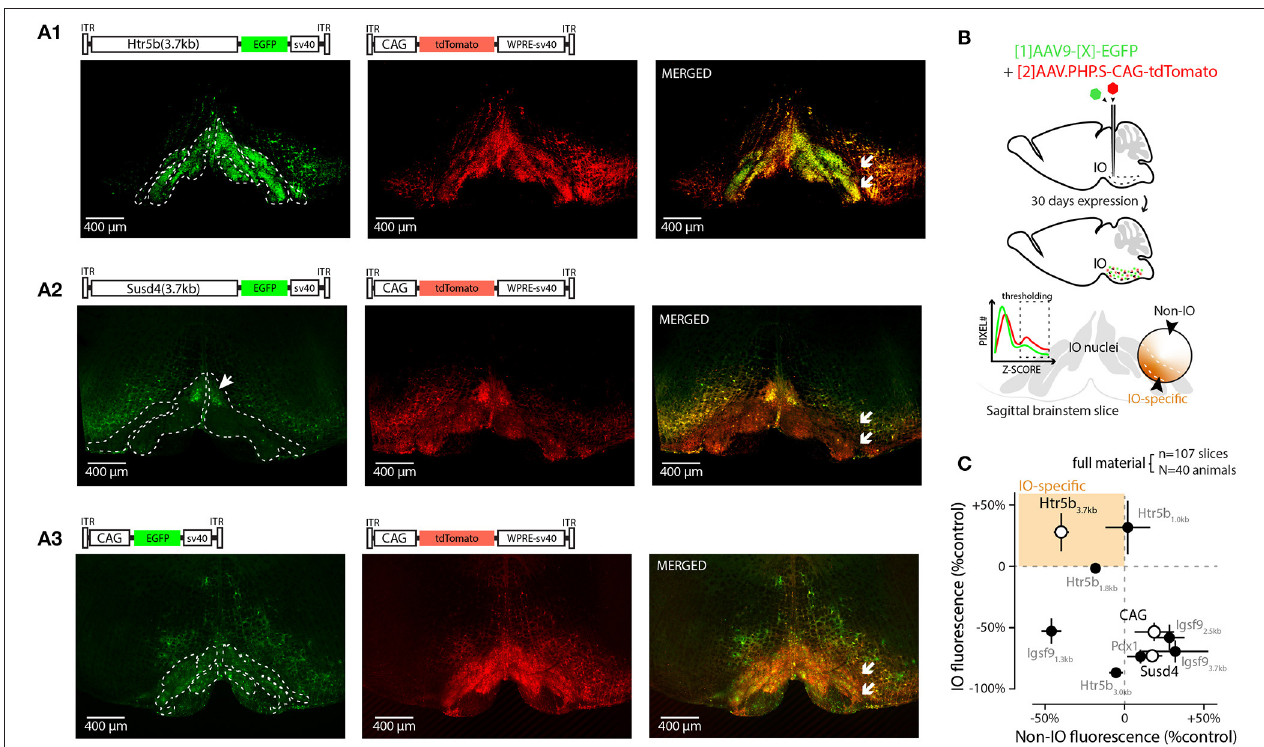
FIGURE 1 | Screening 10 viral constructs for efficient and selective transgene expression in the inferior olive. (A) Confocal images showing EGFP (left) fluorescence driven with three example promoters (Htr5b(3.7), Susd4(3.7), and CAG in (A1,A2,A3) , respectively). Middle shows the tdTomato fluorescence driven with the reference construct (AAV.PHP.S-CAG) that was used to normalize the intensity measurements in each sample; the merged fluorescence images are shown on right. White arrows in merged images indicate the sites of injection on one side of IO, showing that the injections included a purposeful “mistargeting” for more fair assessment of labeling specificity. The plasmid used for each construct is schematically depicted above the confocal images. (B) Schematic describing the definition of IO-specific and non-specific measurements. (C) Summary of all the 10 constructs’ normalized expression strengths inside and outside of the IO (vertical and horizontal axes, respectively). Only constructs based on clones of the serotonin receptor 5b (Htr5b) show similar or better performance in the IO than the reference construct. The results from the three example constructs shown in (A) are indicated by white markers. The error bars denote population